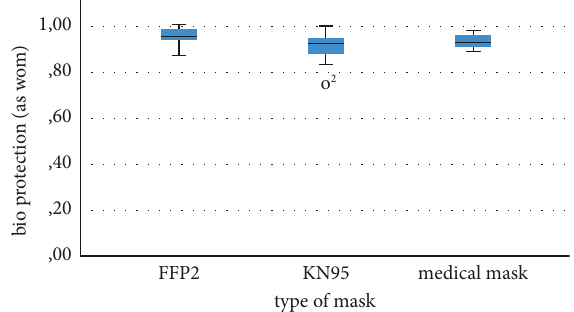
Figure 2: A practical mask test rig with an atomizer (left), a particle-tight chamber with a standardized test head (middle), an impinger and a vacuum pump (right).